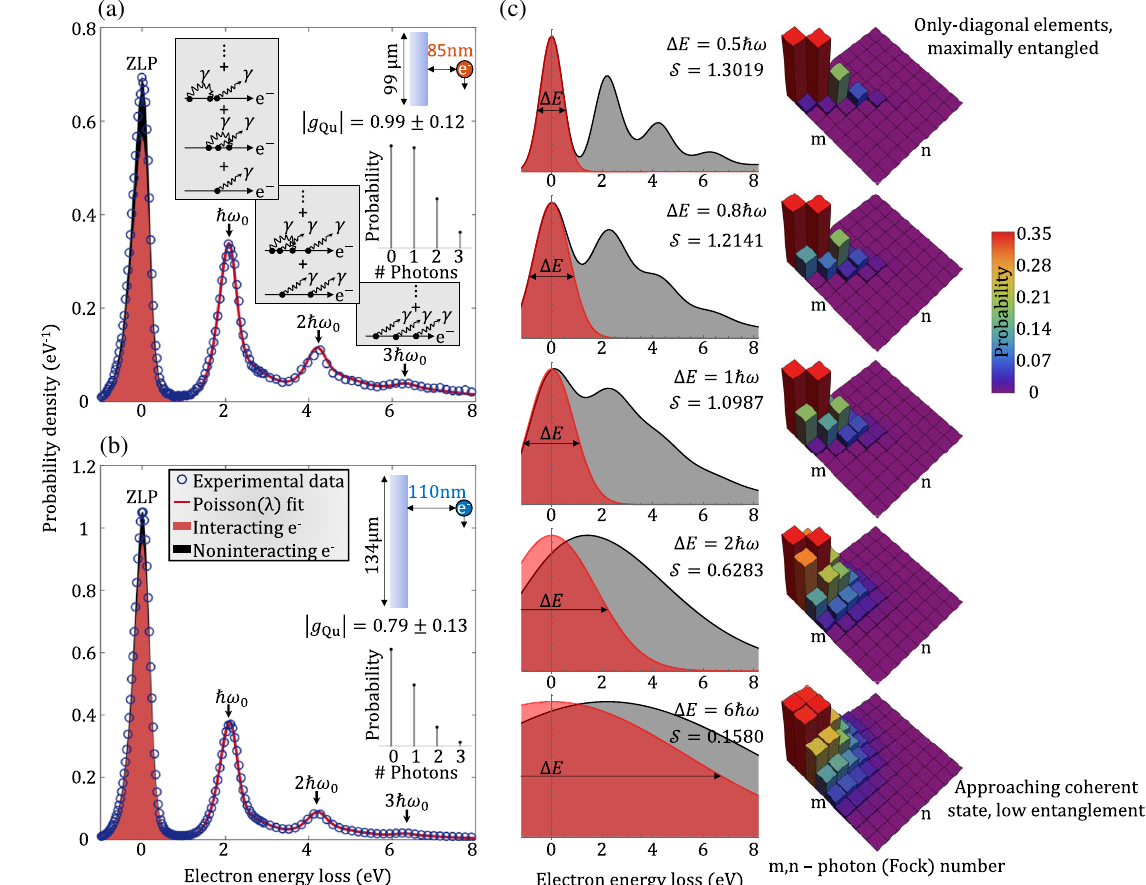
FIG. 4. Measurement of quantized radiation by free electrons: high-order emission of multiple photonic quasiparticles. (a),(b) EELS measurements of 200 keV electrons (blue circles) for two different impact parameters and effective interaction lengths reveal the quantized photonic nature of 2D CR by showing multiple peaks equally separated by the PQP energy. The suggested model [solid red curve, Eq. (2)] follows the recorded data precisely and allows the extraction of various parameters: (i) the total probability to emit zero, one, two, or three PQP (shown in the inset) — this probability follows a Poisson distribution according to the Feynman diagrams in (a) that include multiple emission and reabsorption events in each multiphoton emission process — (ii) a fairly substantial quantum ffiffiffi p j ¼ λ coupling strength j g with λ being the Poisson distribution parameter; (iii) the ratio between the electrons that do and do not Qu interact (red and black filling of the ZLP peak, respectively). No features are observed in the gain side of the spectra. (c) Theoretical analysis of the joint electron-PQP state, showing conditions for the emitted photons to be in an entangled state with the emitting electron and how they depend on the electron (coherent) energy uncertainty. EELS (left column) and the corresponding photonic density matrix in the Fock basis (for the peak frequency; right column) are simulated for different values of electron energy uncertainty using j g j 2 ¼ 1 , to resemble the case in (a). Each EELS is found by tracing out the photonic part of the joint density matrix, whereas each Qu photonic density matrix is found by tracing out the electron part. The top row shows the case of an electron energy uncertainty narrower than the photon energy that creates a maximally entangled electron-PQP state. The bottom row shows the case of an electron energy uncertainty much wider than the photon energy, which can represent a short-duration electron pulse that creates a separable electron- PQP state with a Glauber coherent (classical) PQP state. See Supplemental Material [64] and Appendix A for additional details regarding the quantum description of the process, parameter extraction, and data analysis. To quantify the degree of entanglement between the electron and its emitted photons, the von Neuman entropy S is calculated theoretically [76] for each of the above cases. The ¼ 1 is 1.3048, and for Δ E ¼ 0 . 5 ℏ ω , we reach an entropy of 1.3019, which is a signature of maximal possible entropy for the case of g Qu the strong correlations between the electron and the photons — which are close to be in a maximally entangled state (see Supplemental Material, Note 3.3 [64], for further